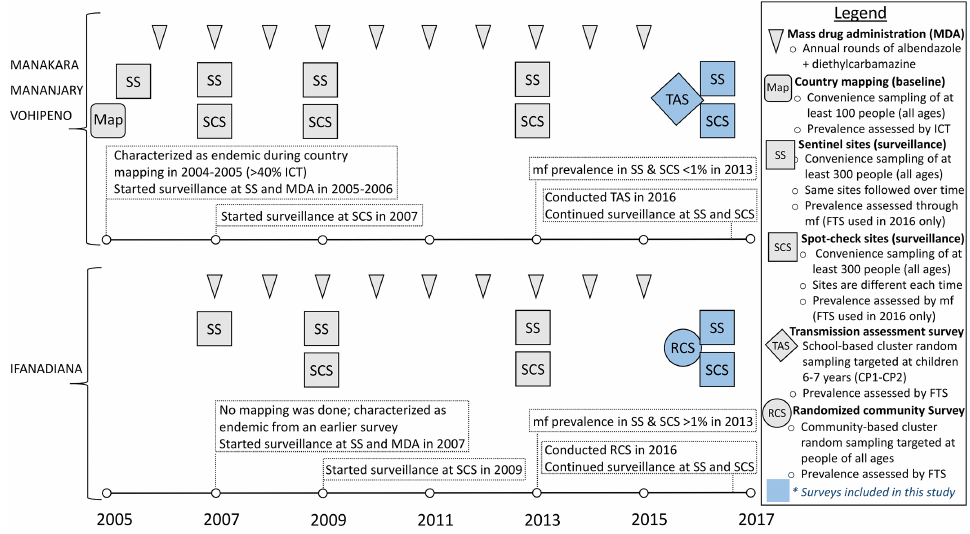
Fig 1. Chronology and main characteristics of mass drug administration, monitoring and evaluation implemented in the four health districts included in this study, Vatovavy Fitovinany region. Source : Madagascar Ministry of Health, National Programme for the Elimination of Lymphatic Filariasis.